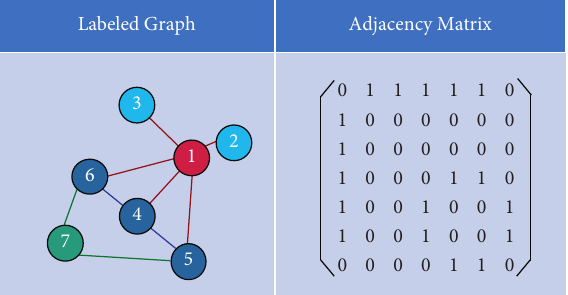
Figure 1: Transformation of the graph structure into an adjacency matrix without